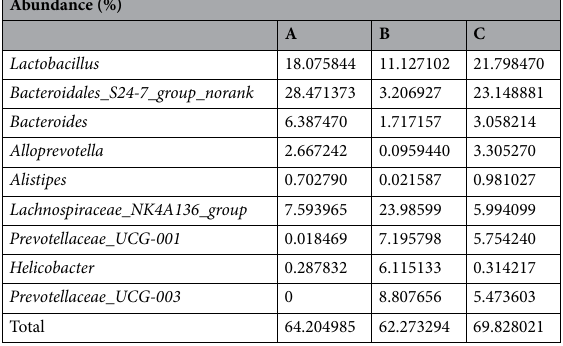
Table 4. The relative abundance of the main gut microbiota at the genus level in four